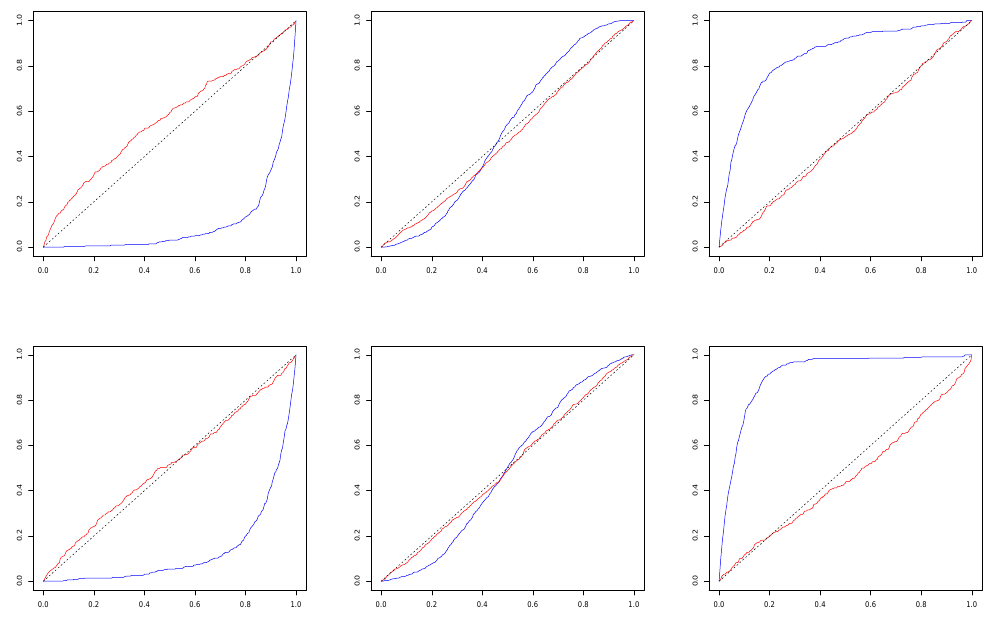
Figure 3. Conditional Ccumulative Distribution Function Estimates (blue: h = 0; red: h = 1) ( Upper row : rvix | rsp; Lower row : rsp | rvix. Left : A = (0, 0.05]; Middle : A = [0.45, 0.55]; Right : A = [0.95,